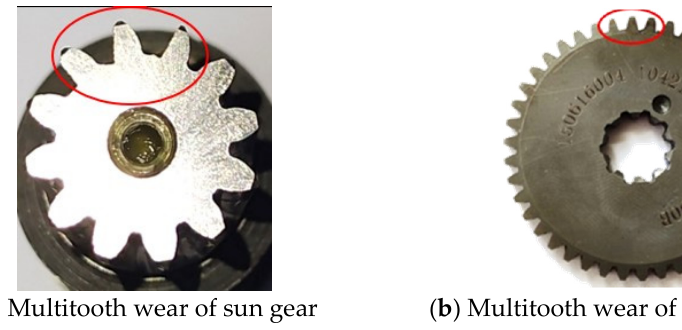
Figure 9. RV reducer fault pictures.